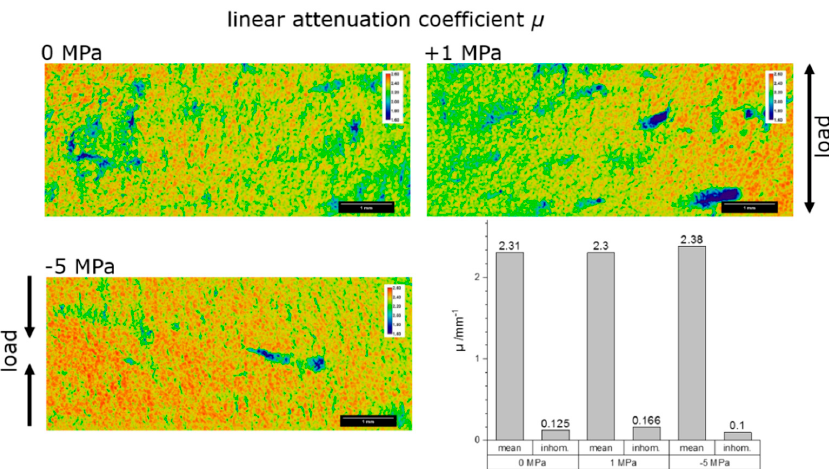
Figure 6. Visualization of the local values of the linear attenuation coefficient µ as 2D color-coded images (top left), unloaded (top right) 1 MPa tensile loaded and (bottom left) 5 MPa compression loaded. Bottom right: The integral values of the linear attenuation coefficient µ across the loaded and unloaded specimens are shown as bar graphs. The small bars represent the inhomogeneity of the µ values across the measured area of the specimen.